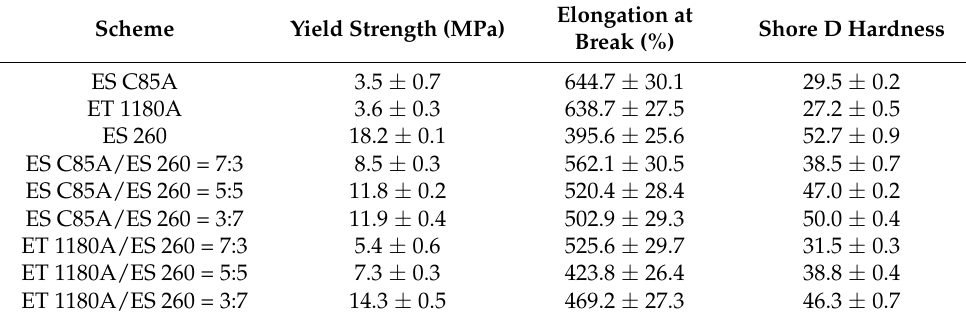
Table 3. Mechanical property data of neat TPU and TPU